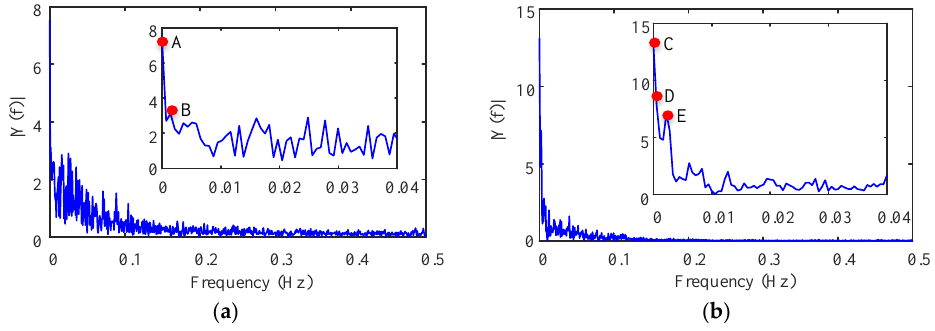
Figure 6. The spectral analysis of the load current: ( a ) the urban dynamometer driving schedule (UDDS) test; ( b ) the worldwide harmonized light vehicles test procedure (WLTP) test.